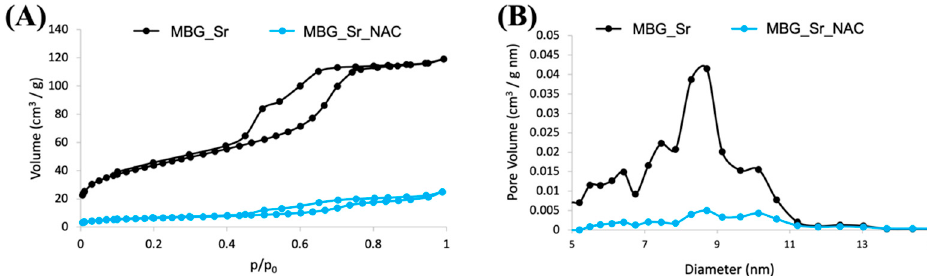
Figure 7. FE-SEM image of MBG_Sr_NAC.